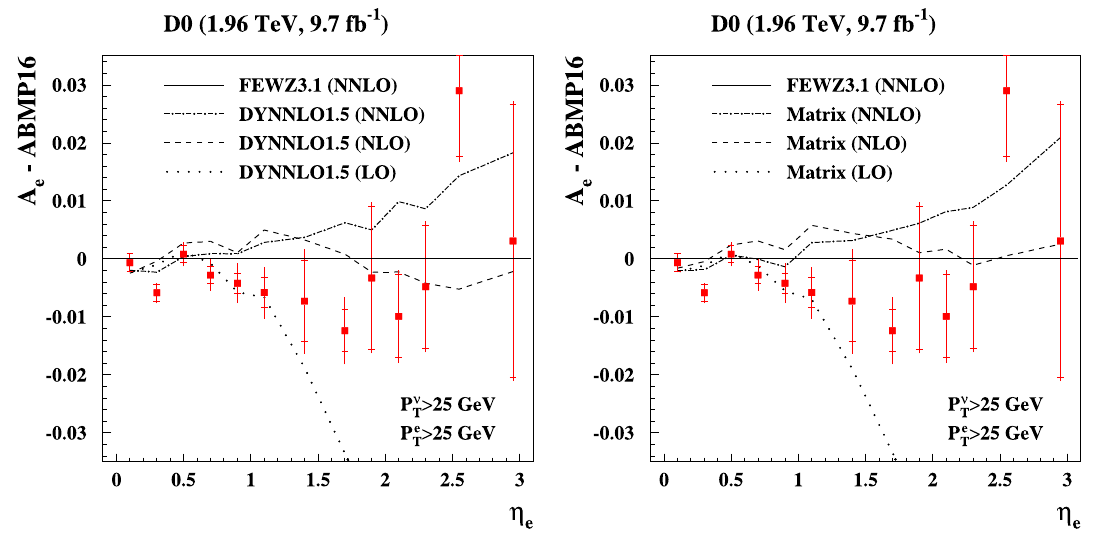
Fig. 11 The DØ data on the electron charge asymmetry distribution NNLO obtained with FEWZ . The symmetric p e ,ν √ A e in W ± -boson production at s = 1 . 96 TeV with the statistical tons are indicated in the figure. The LO (dotted), NLO (dashed-dotted) and NNLO (dashed) predictions by the DYNNLO code (left) and by the (inner bar) and the total uncertainties, including the systematic ones. MATRIX code (right) are displayed for comparison Shown is the difference of A e to the ABMP16 central predictions at